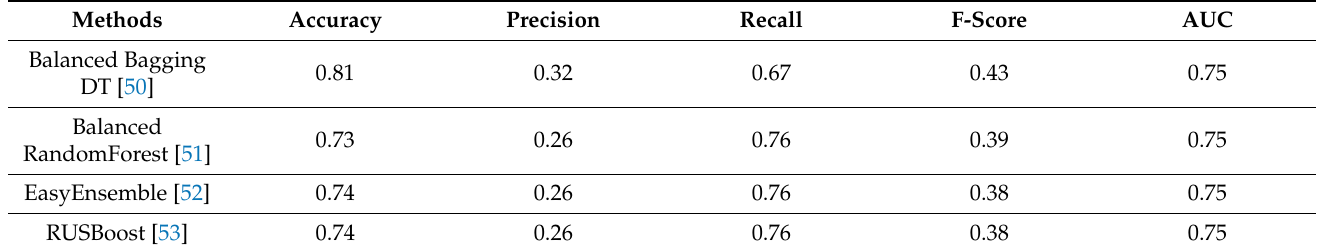
Table 5. Results of the over-sampling-based